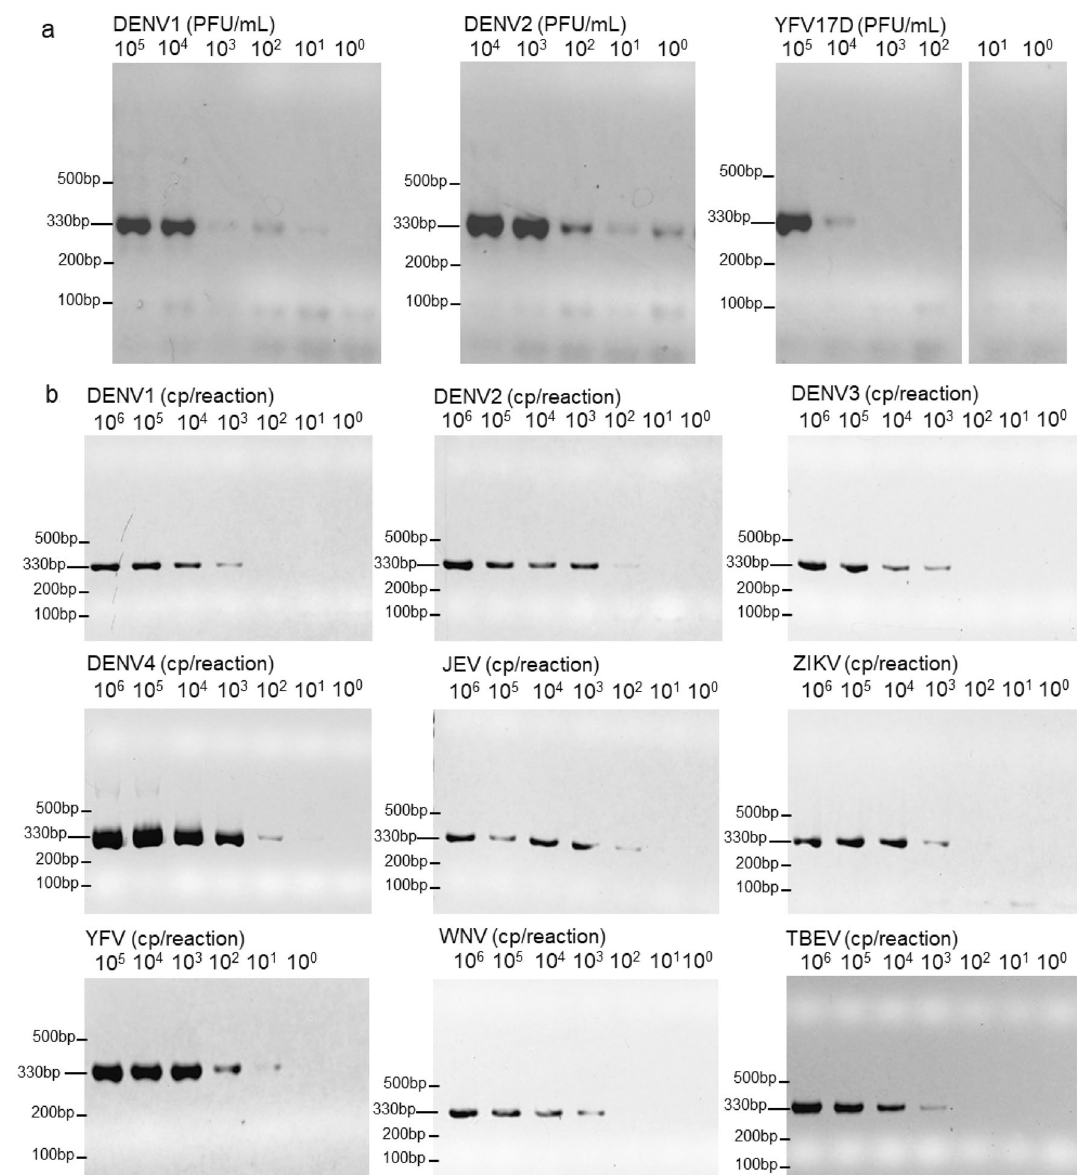
Figure 1. Sensitivity of PCR using the modified pan-flavivirus primers. ( A ) Fetal bovine serum were spiked with DENV1, DENV2, and YFV viral particles. RNAs were extracted from them then used as PCR template. ( B ) Plasmids containing the indicated sequences were used. Images were cropped from the original. Original image can be found in Supplementary Fig. S3 and S4. DENV Dengue Virus, JEV Japanese Encephalitis Virus, ZIKV Zika Virus, YFV Yellow Fever Virus, WNV West Nile Virus, TBEV Tick Borne Encephalitis